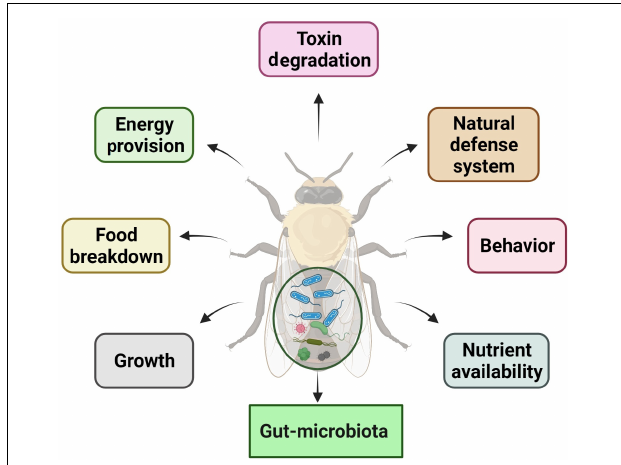
FIGURE 2 | Functions and impacts of gut microbiota on insect biology and